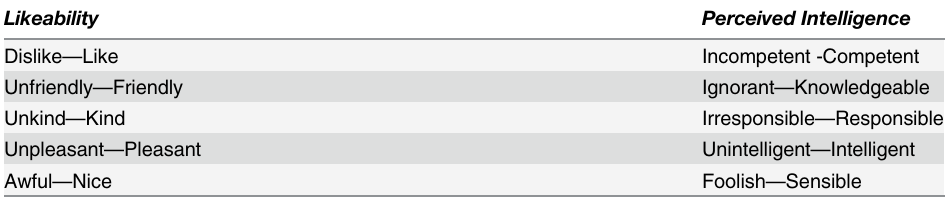
Table 1. Semantic pairs for Godspeed Scale dimensions used.